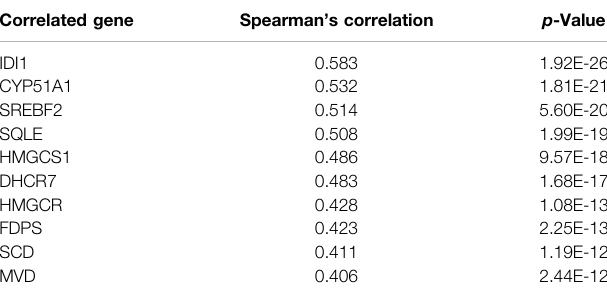
TABLE 2 | Top 10 genes correlation with MSMO1 in